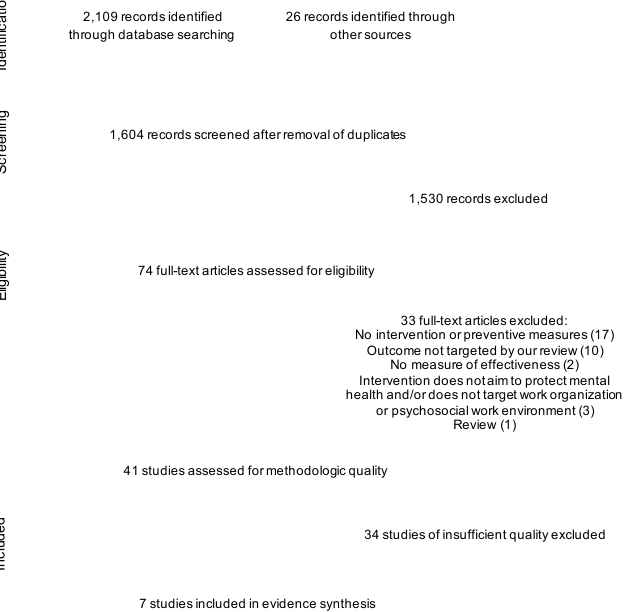
Figure 1. PRISMA flowchart detailing the identification and selection of studies.